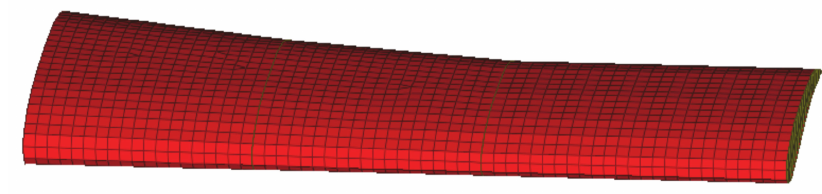
Figure 9. Finite element model of the wing structure. Table 9. Accuracy verification of the response surface.